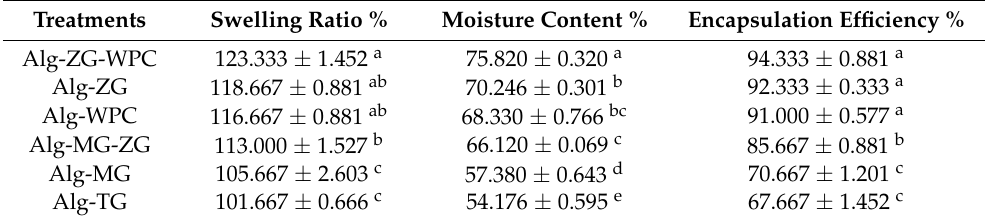
Figure 7. The XRD spectra of different biopolymers (zedo gum, alginate, and whey protein), alginate-zedo gum-whey protein, and alginate-whey protein microcapsules. Table 1. The results of the evaluation of moisture content, swelling ratio, and encapsulation efficiency of B. velezensis microcapsules prepared by different